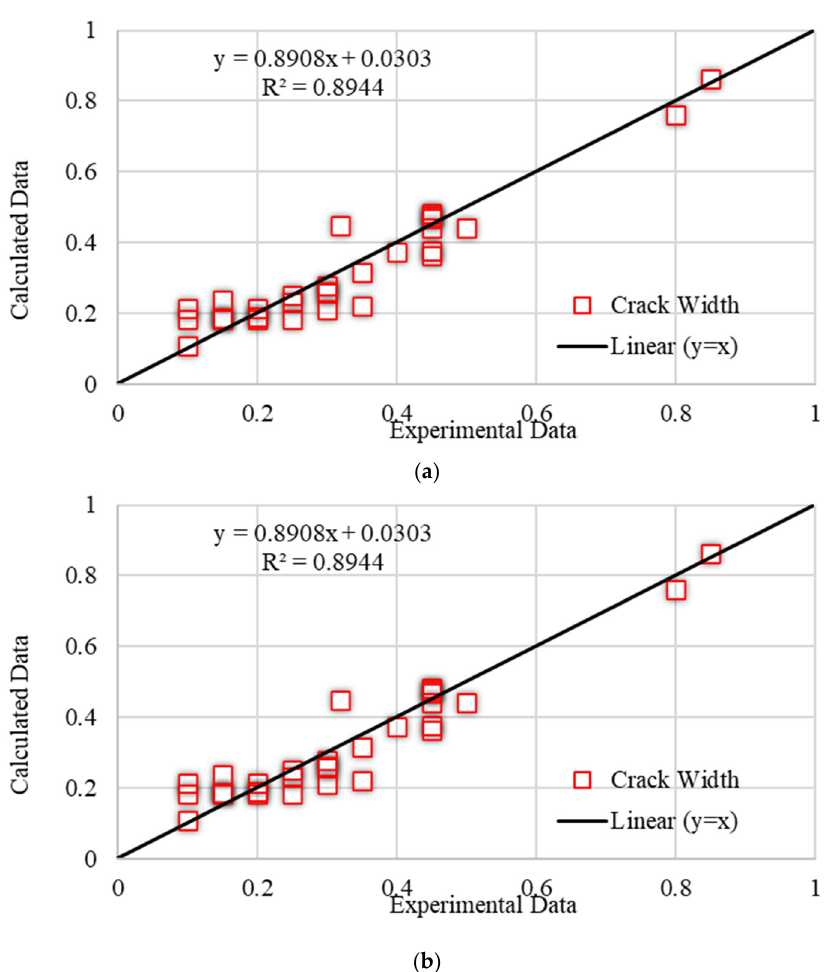
Figure 17. Experimental versus predicted values for estimating crack width using GWO-ANN: ( a ) Training data, ( b ) Testing data.